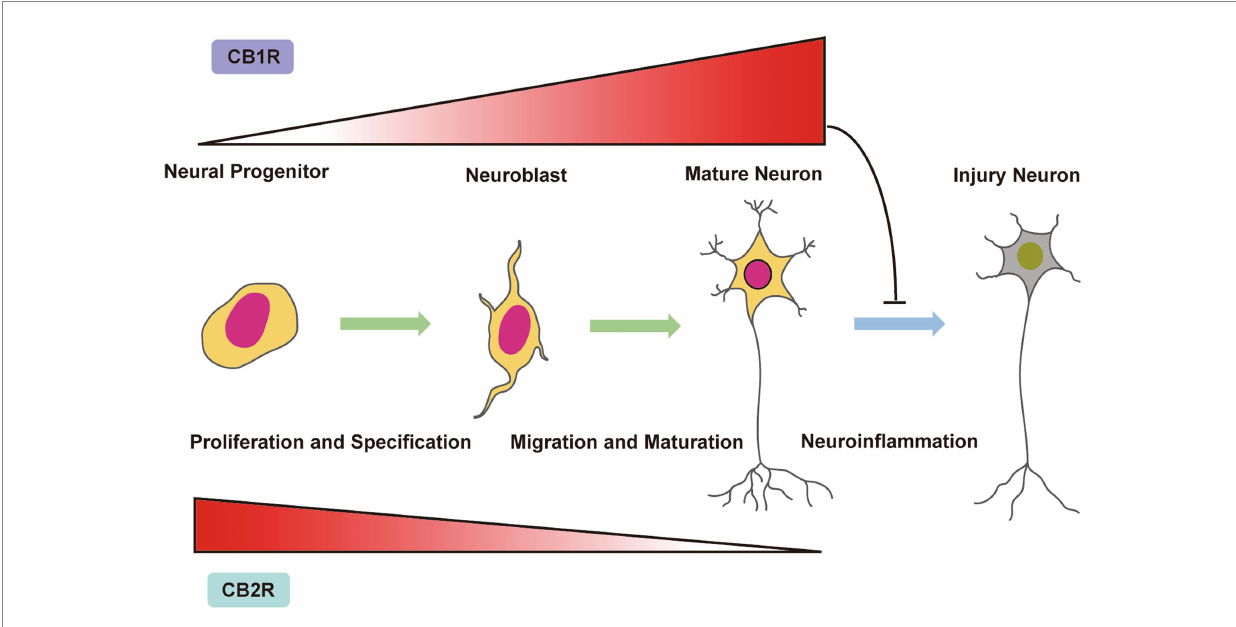
FIGURE 2 Endocannabinoid system control of neurogenesis and neural cell fate in the immature brain. CB1 receptor expression is present in neural progenitors (NPs) and increases during neuronal proliferation, differentiation and maturation. In contrast, the CB2 receptor is present in NPs and is downregulated upon neuronal proliferation, differentiation and maturation. During neuronal development, CB1 and CB2 receptors control NP proliferation, neuroblast migration and neuron maturation. Under neuroinflammatory conditions, activation of CB1 receptors has been shown to restore adult neurogenesis and decrease the number of injured